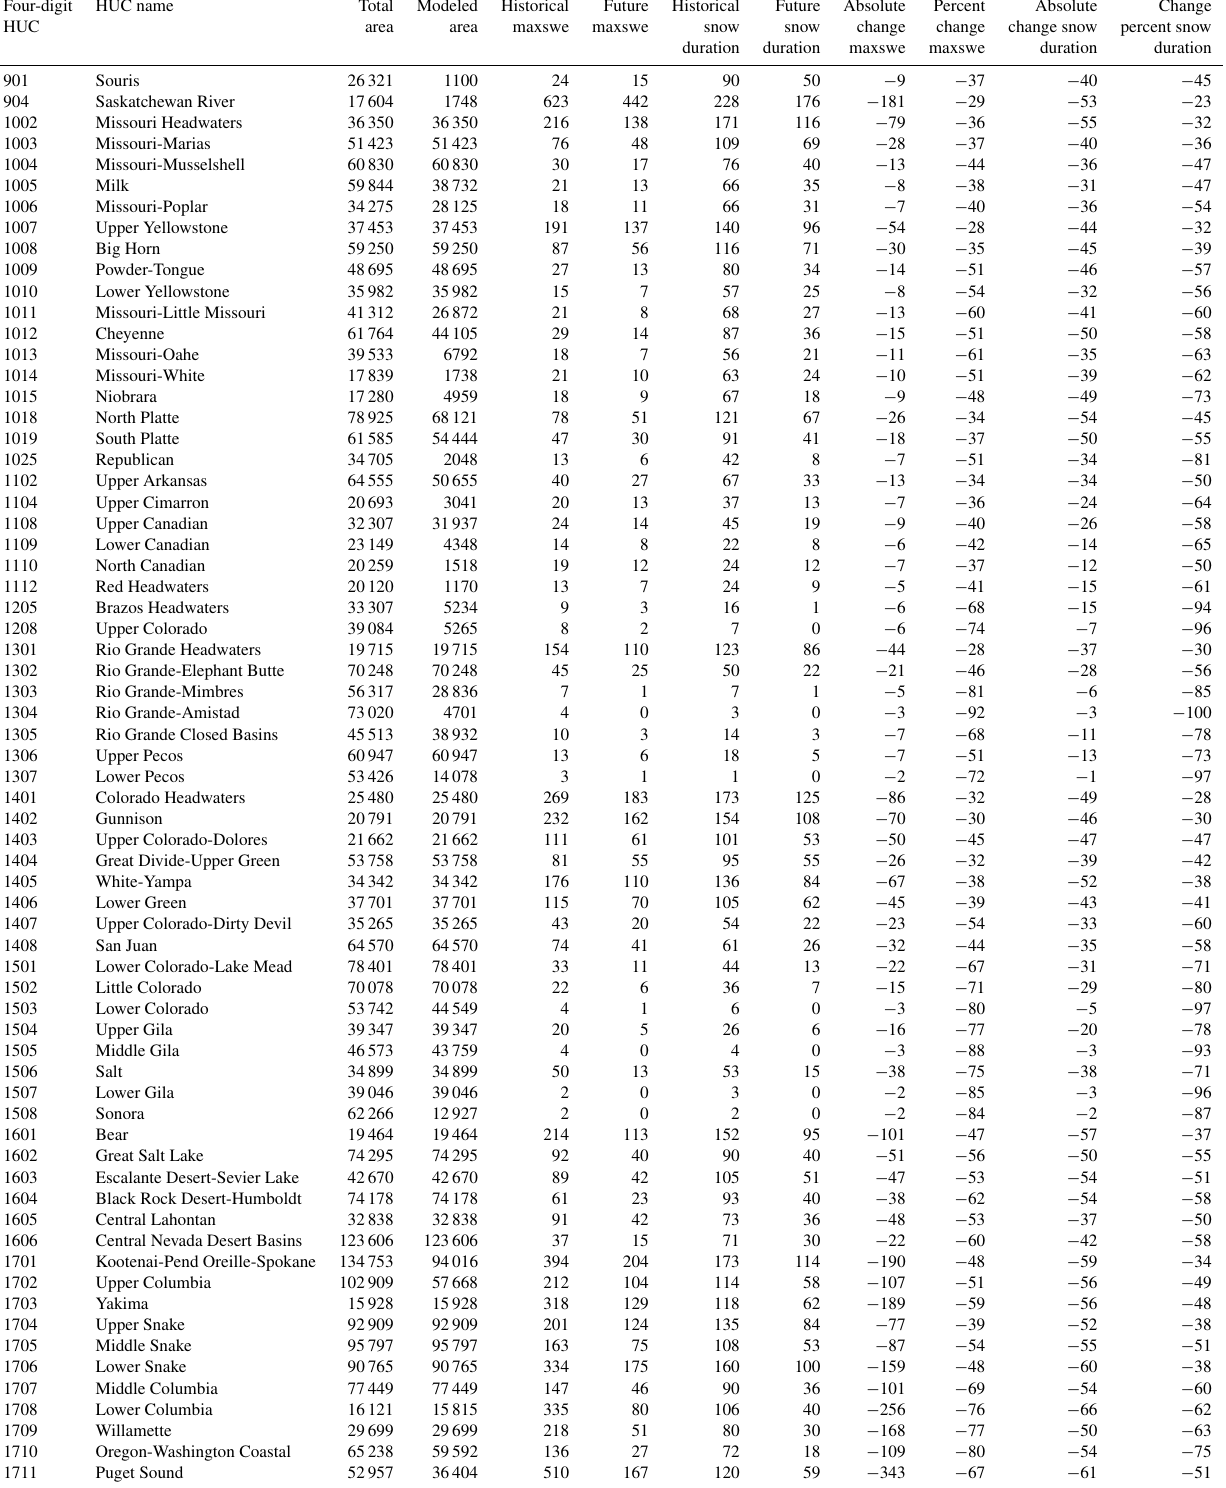
Table B1. Summary of snow metrics by four-digit HUC. Total and modeled areas are in square kilometers, maxswe has units of millimeters, and snow duration has units of days. Values are averaged over all modeled grid cells within each HUC. Total snow metric values (in the last row) are averaged across all grid cells across the western US modeling domain, and total changes are computed from these total snow metric